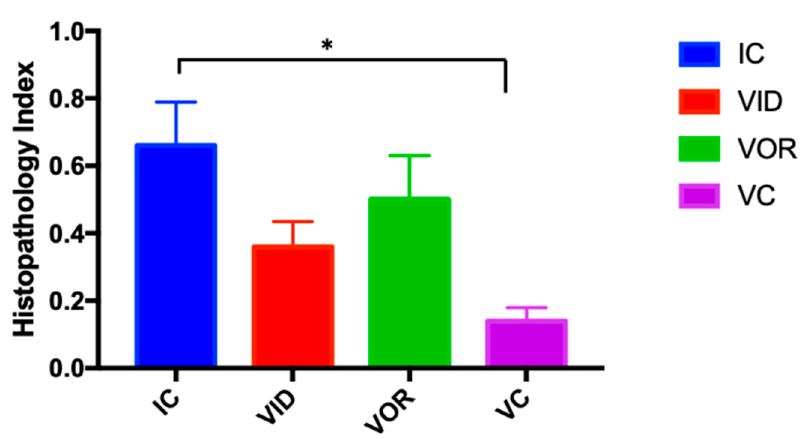
Figure 3. Histopathology index calculated as the sum of the scores per tissues divided by the number of examined tissues of the experimental groups. Error bars represent the standard error of the mean. * p < 0.05.